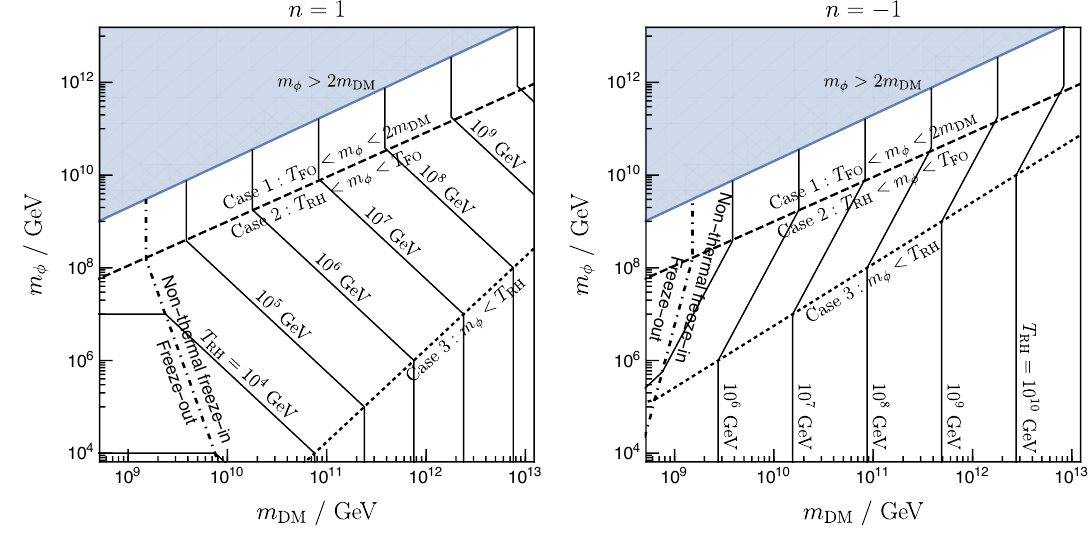
Figure 9 . Contours of the reheating temperature T RH required to produce the observed dark matter abundance by LSP production during reheating. In the blue region, direct decay of the inflaton into sparticles overproduces the LSP. To the right of the dot-dashed line, radiation is not thermalized by the would-be freeze-out, and the LSP production occurs just before the completion of